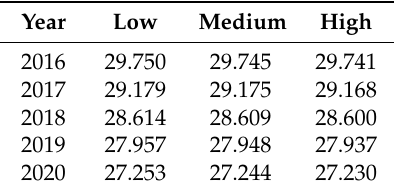
Table 6. Forecasting forest areas by using medium GDP and low, medium, and high population growth (unit: 10 6